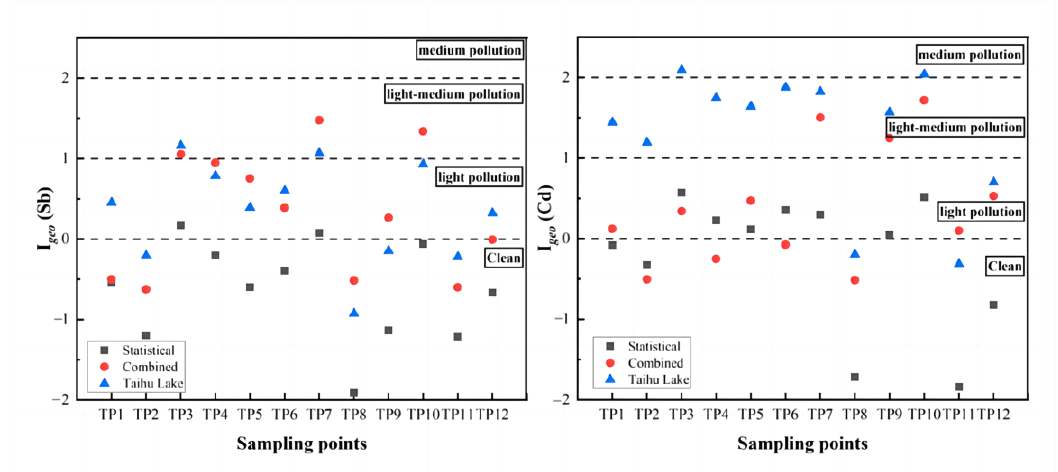
Figure 6. The values of I geo of Sb and Cd in Taipu River surface sediments, evaluated based on BV calculated from statistical method (standard deviation), combined method (uncontaminated samples + standard deviation) and values quoted from the Taihu Basin [61].